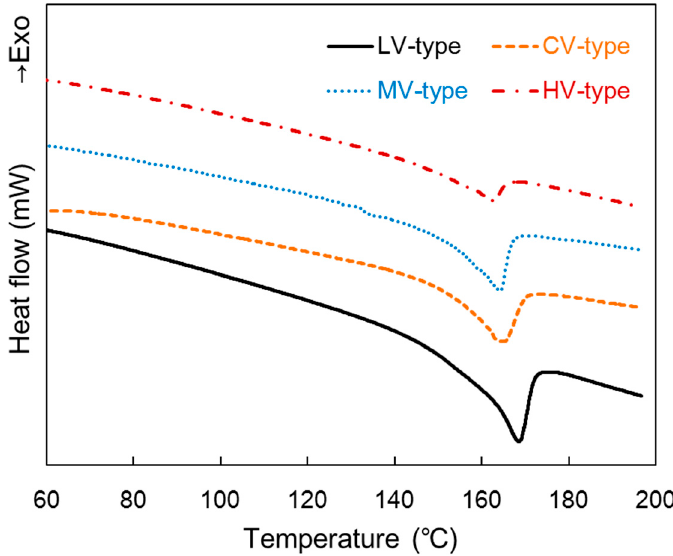
Figure 4. Differential scanning calorimetry (DSC) patterns of the composites produced at a pressure rising time of 25 min.